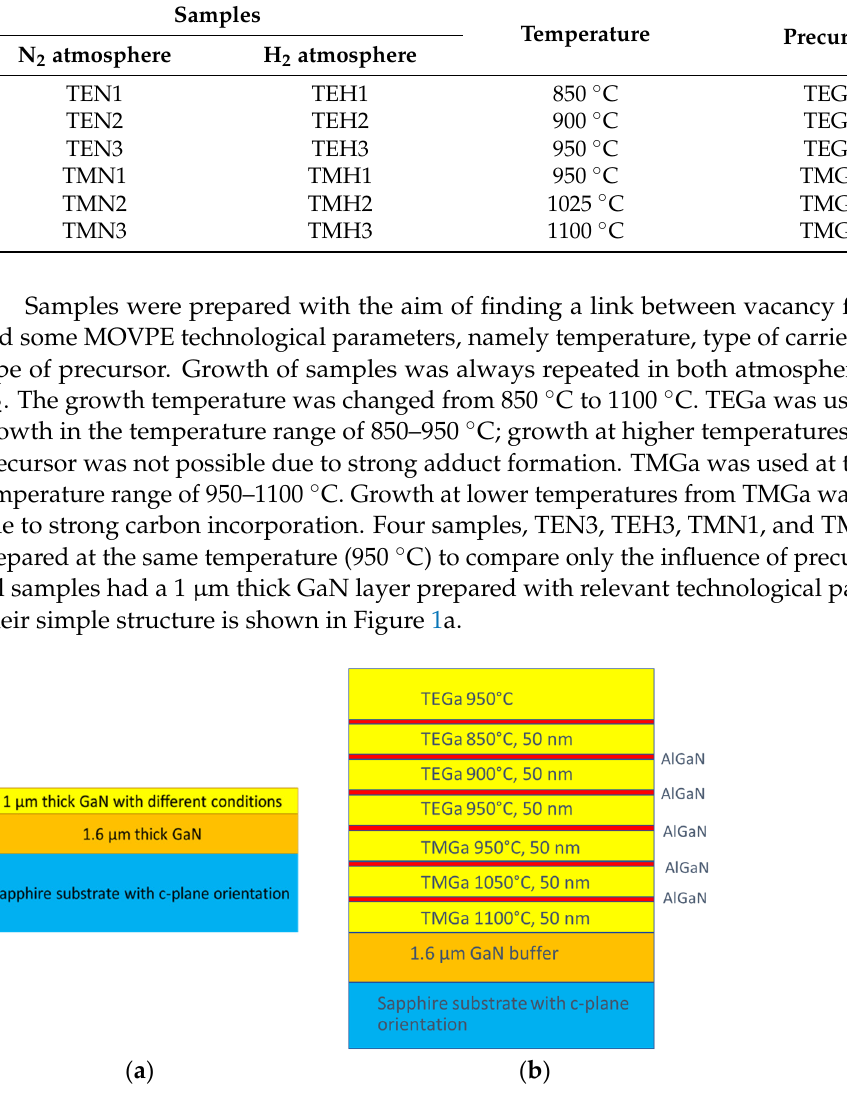
Figure 1. ( a ) Structure of samples prepared for VEPAS and PL measurement, ( b ) Structure of sam- ples prepared for